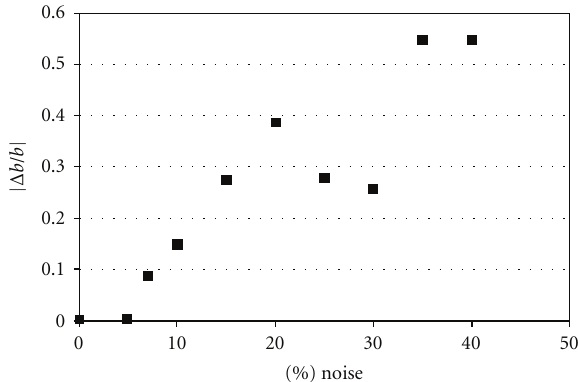
Figure 12: Absolute relative error in the calculation of depth against noise percentage.